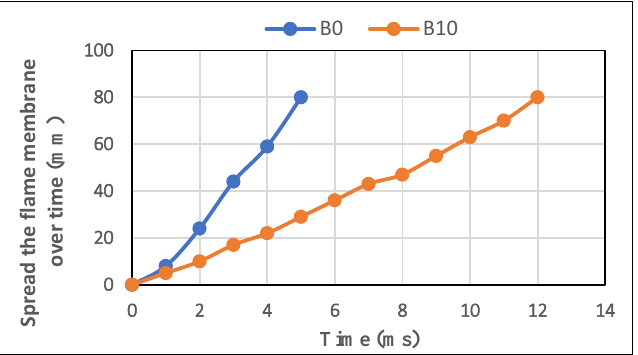
Figure 6. Spread of the flame membrane over time in the CVCC combustion chamber.